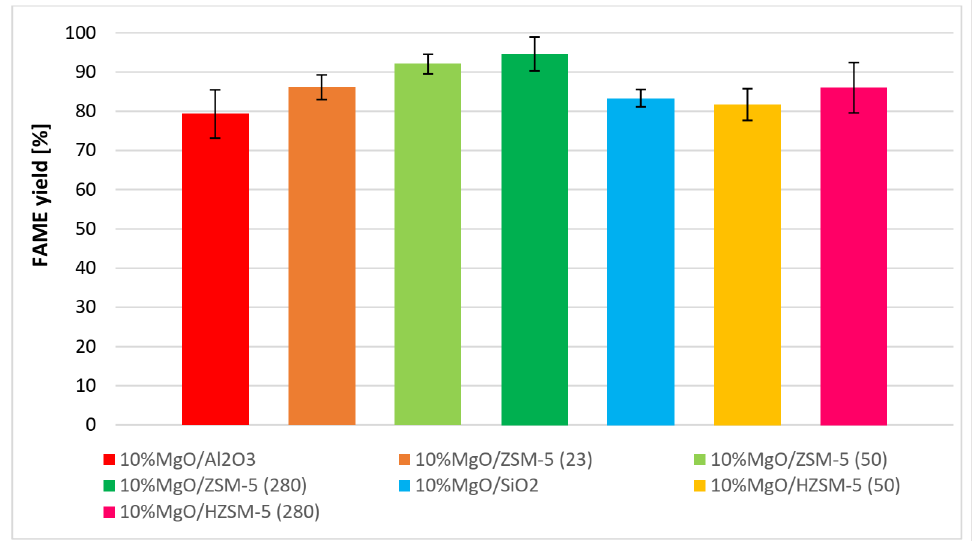
Figure 2. FAME yields obtained for the investigated MgO based catalytic systems. The ratio of silicon to aluminum is given in